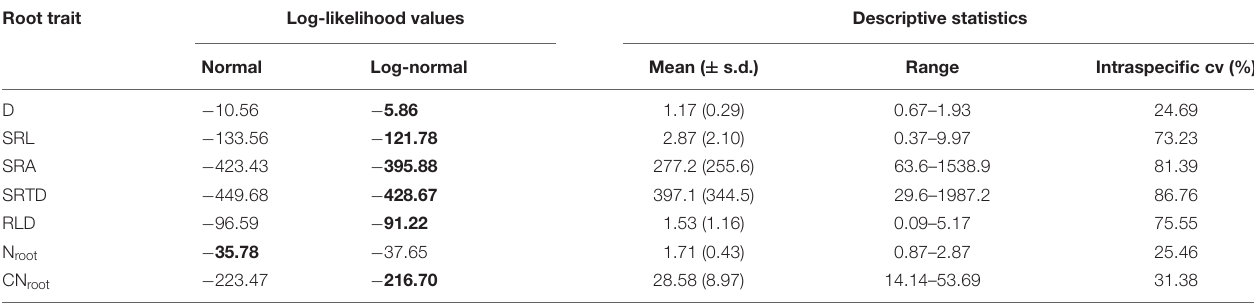
TABLE 2 | Intraspecific variation in roots traits of C . arabica . Root